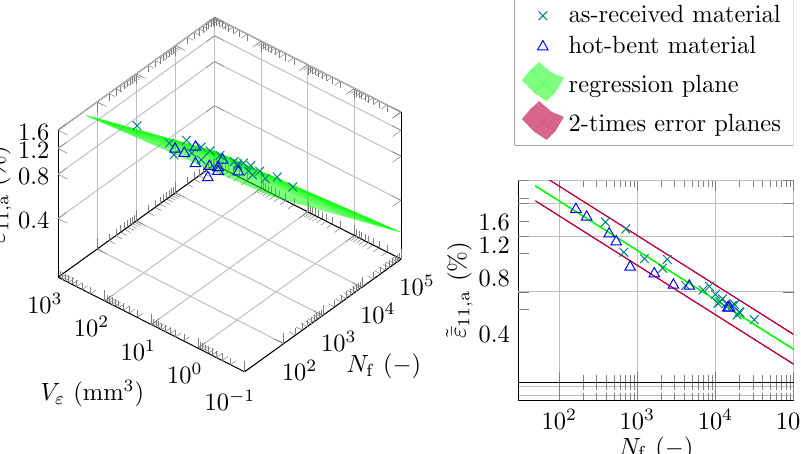
Figure 12. 3D and 2D ˜¯ ε 11,a - V ε - N f fatigue diagrams including the results from the fatigue tests of the hot-bent and as-received specimens, the regression surface (green color), and the two 2-times error planes (red color). For the fatigue diagrams, the mean effective strain amplitude ˜¯ ε 11,a is